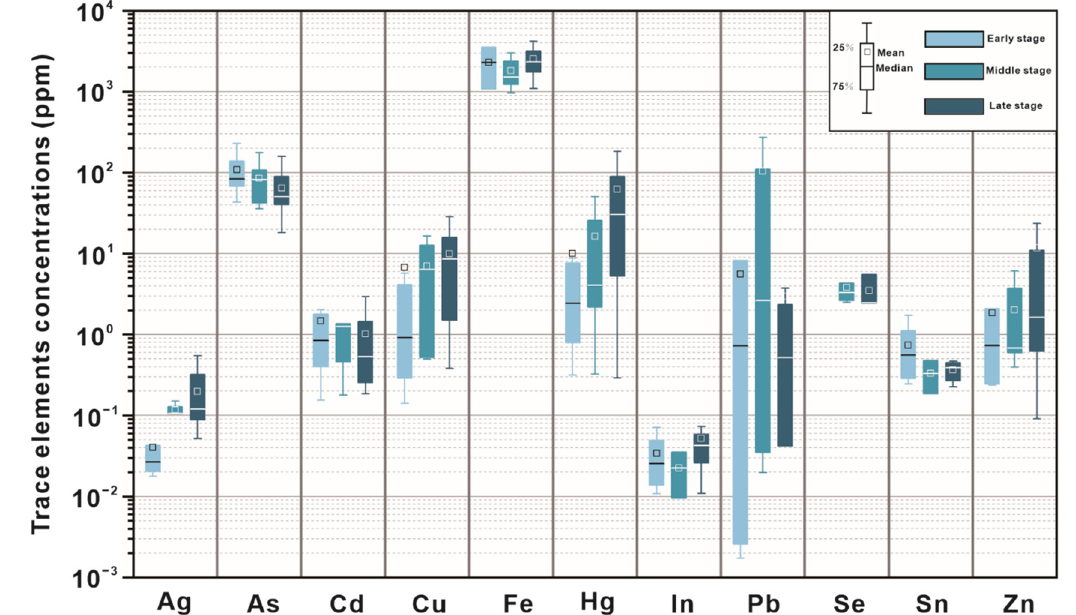
Figure 8. Trace element data of stibnite in the three mineralization stages of the Daocaowan Sb deposit determined by LA-ICP-MS. All values are in ppm.